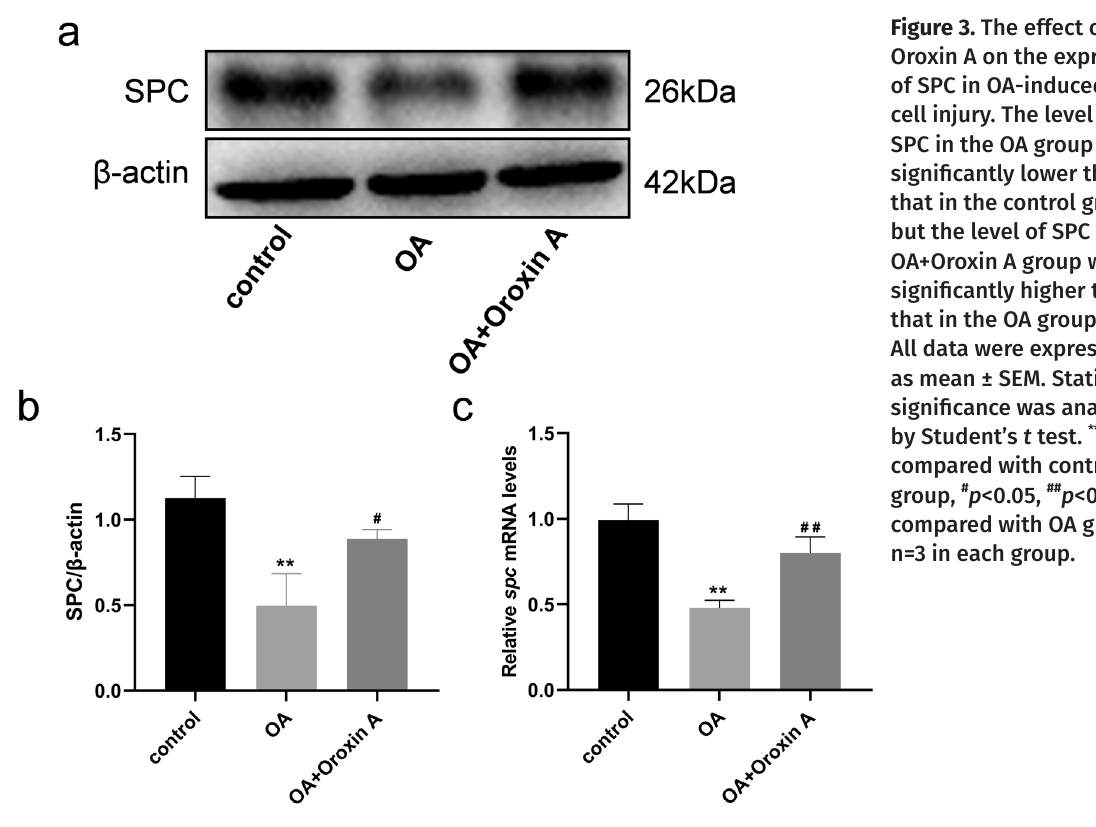
Figure 2. The levels of IL-1β, IL-18 and LDH in the cell culture medium were determined. The levels of IL-1β, IL-18 and LDH in the OA group were significantly higher than that in the control group but the level of IL-1β, IL-18 and LDH in the OA+Oroxin A group was significantly lower than that in the OA group (a-c). All data were expressed as mean ± SEM. Statistical significance was analyzed by Student’s t test. ** p <0.01, *** p <0.001 compared with control group, ## p <0.01, ### p <0.001 compared with OA group, n=3 in each group.